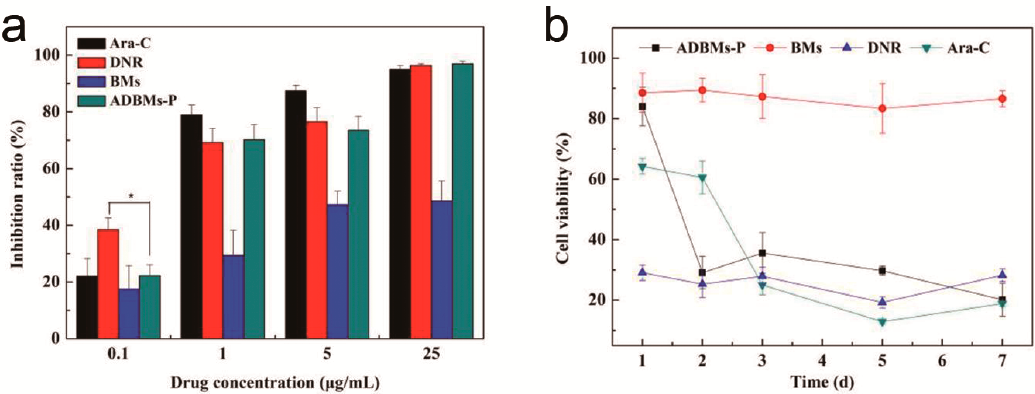
Figure 4. The effect of: concentrations ( a ); and treatment times ( b ) of Ara-C, DNR, ADBMs-P and BMs on the growth of HL-60 cells (* p < 0.05).